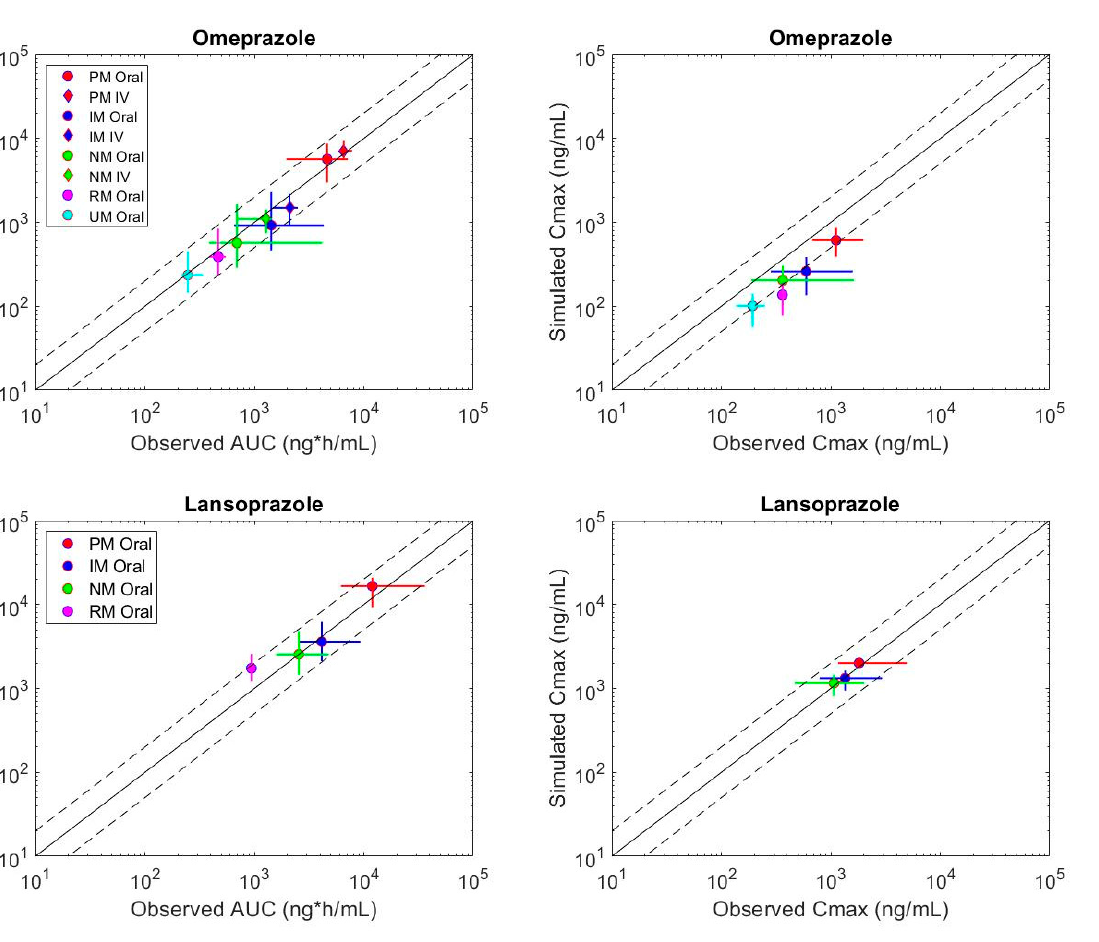
Figure 1. Simulated versus observed median and range of mean AUC and C max values across CYP2C19 phenotypes for omeprazole and lansoprazole. Median of simulated trial means plotted against median of clinical study means. The red, blue, green and magenta vertical lines are range of simulated trial means; horizontal lines are range of clinical study data (see Table 2 for number of studies per phenotype). The solid black line is the line of unity; black dashed lines indicate 2-fold upper and lower acceptance criteria.